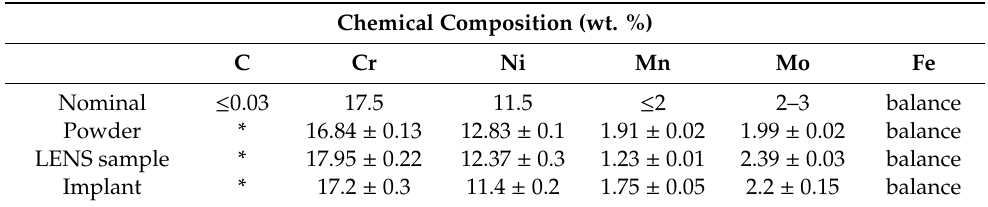
* Beyond the EDS detection range.